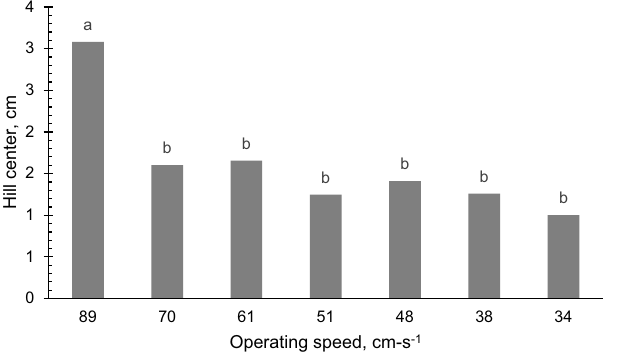
Figure 9. The influence of the different levels of operating speeds (cm s −1 ) on the hill center of carrot seeds. Operating speeds of different letters denote significant difference ( p < 0.005) on the hill center.